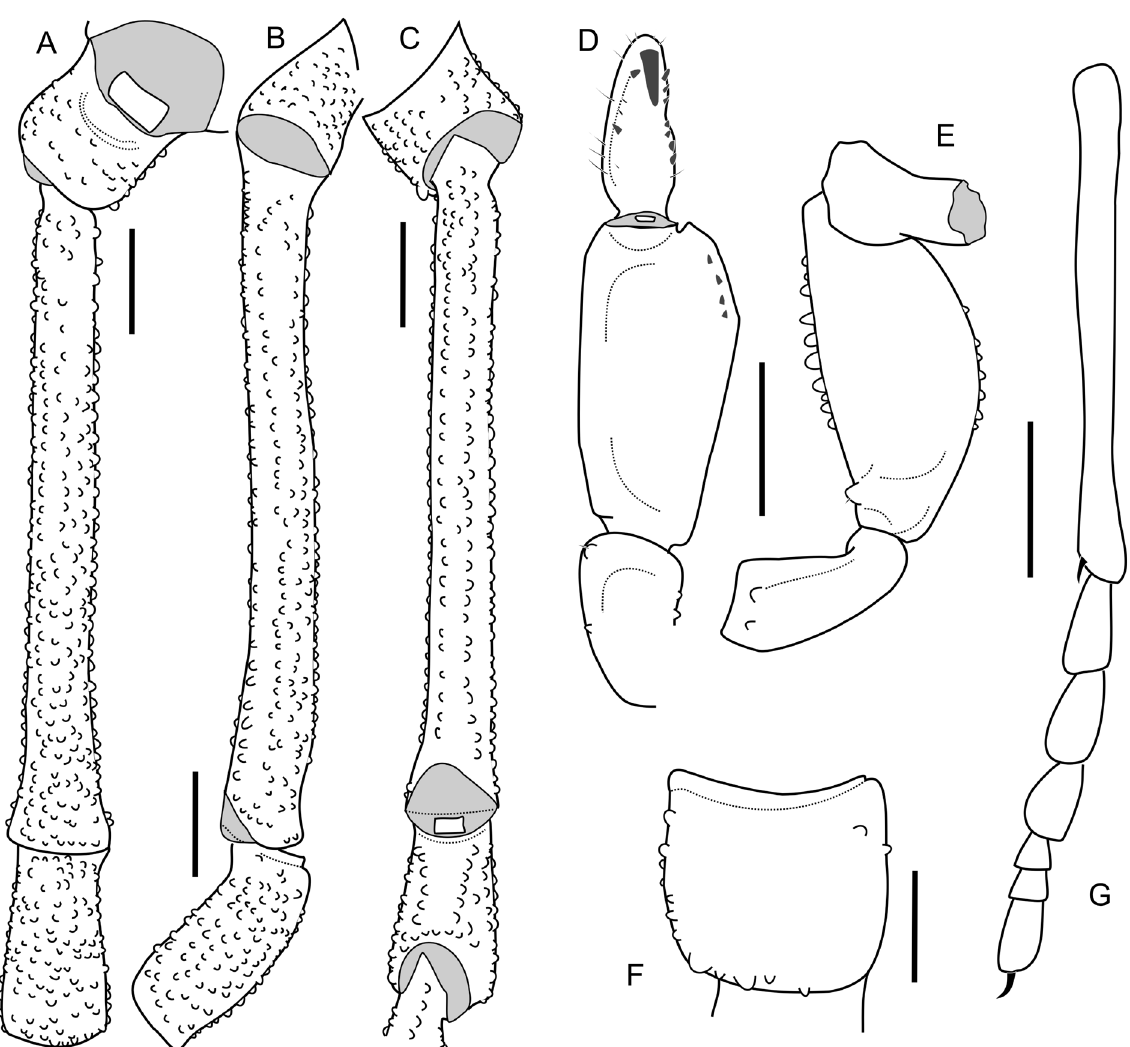
Fig. 10. Eulibitia clytemnestra sp. nov., ♂, holotype (ICN-AO 1148). A . Left femur and trochanter IV, dorsal view. B . Same, prolateral view. C . Same, ventral view. D . Left pedipalpus, tibia and tarsus in ventral view. E . Same, femur and patella in mesal view. F . Left chelicera, dorsal view. G . Left tibia and tarsomeres of leg I, prolateral view. Scale bars: 1